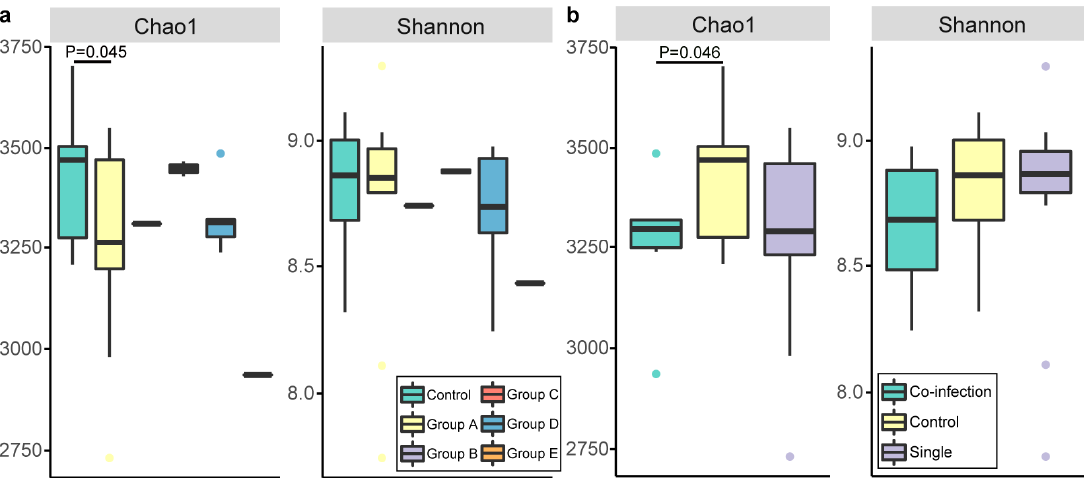
Figure 1. Two alpha diversity measures Chao1 and Shannon’s diversity index. Community diversity represented by Chao1 and Shannon diversity index for samples from each group. Each dot stands for a discrete individual while each color represents ( a ) the samples from the camels infected with different parasites, ( b ) the samples from the camels with non-, single-, co-infection with parasites as the label showed.